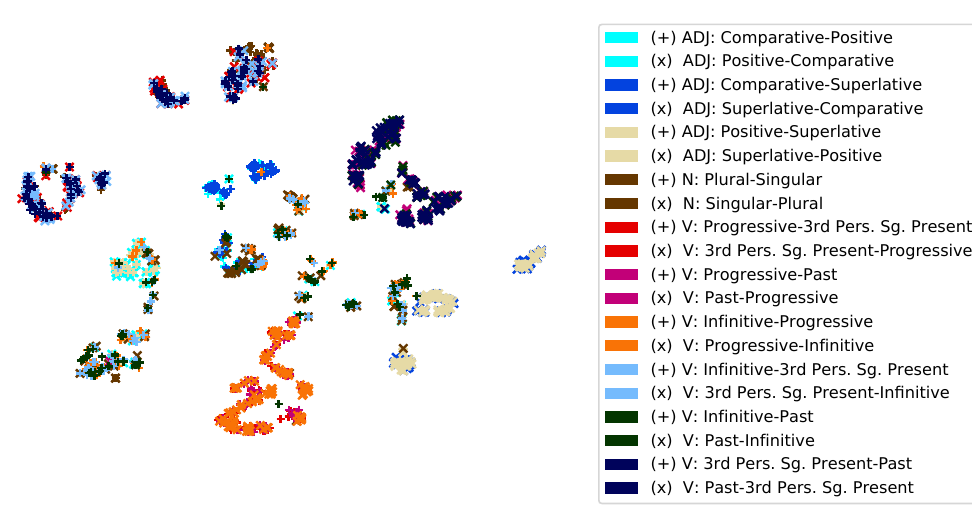
Figure 5: t-SNE visualization of all query words from English validation set em- bedded using the query encoder. Each point is coloured by the relation type that it